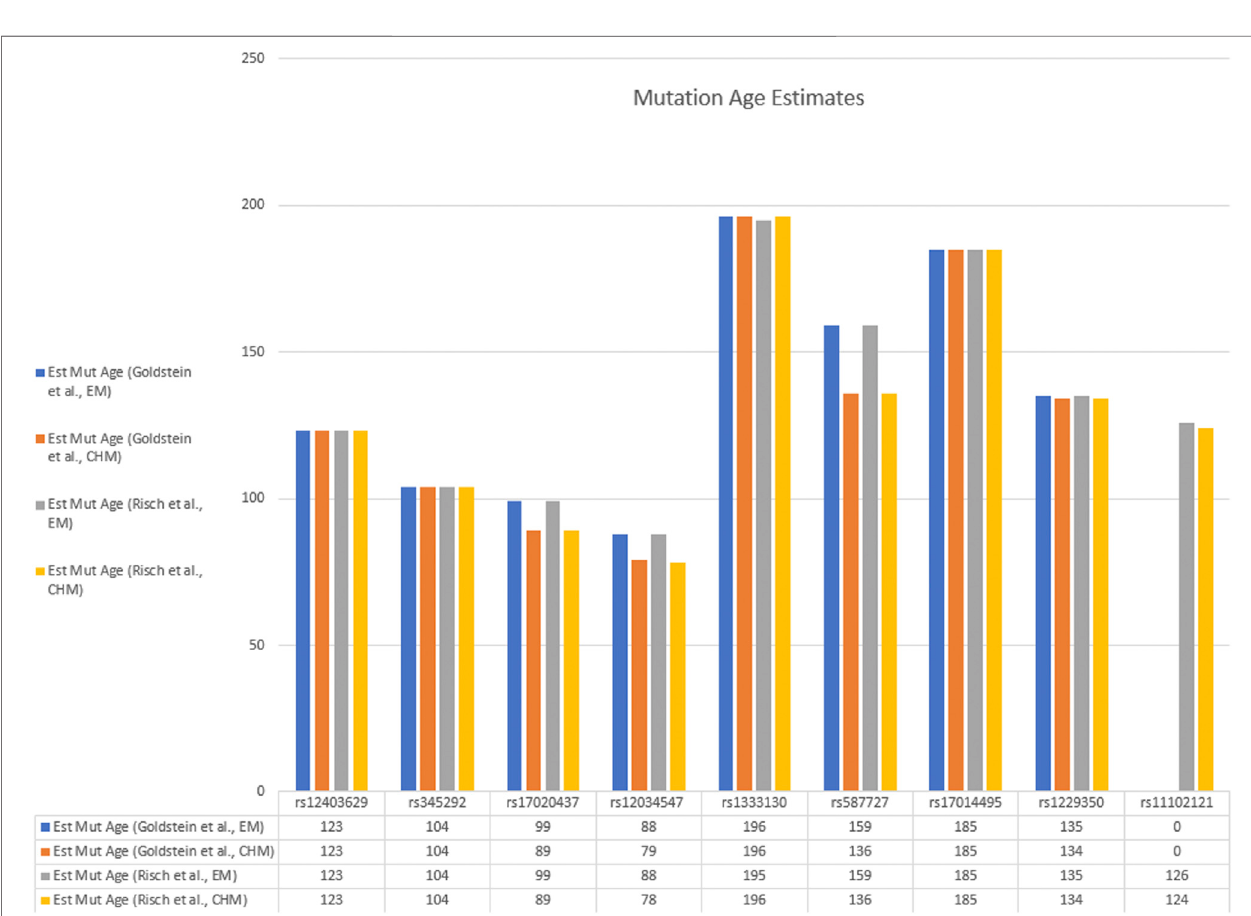
FIGURE 3 | Bar graph of estimated mutation ages from various haplotype blocks by the Goldstein and Risch methods. Data are taken from Table 2 .